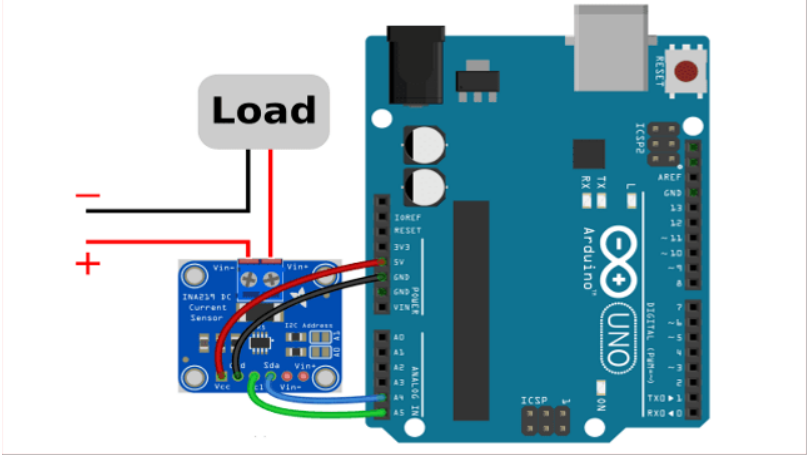
Figure 1. INA219 wiring with the second Arduino